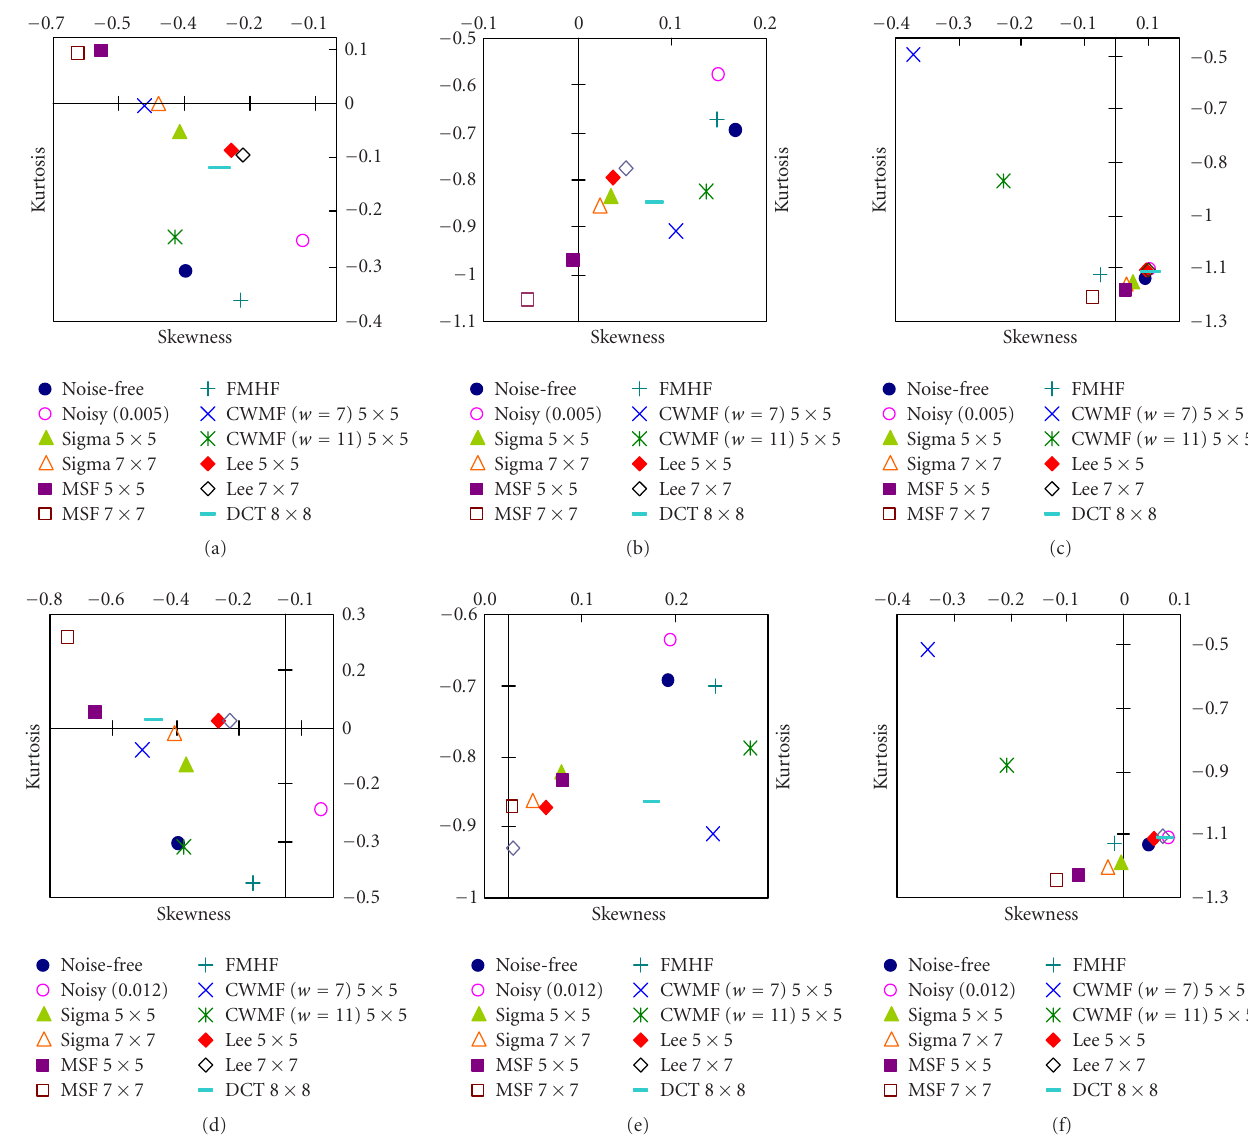
Figure 5: Joint graphical representation of kurtosis and skewness for original and noisy textures and these textures are processed by dif- ferent detail preserving filters: (a), (d) left-bottom, (b), (e) right-bottom, and (c), (f) left-top textures in Figure 1, corrupted by Gaussian multiplicative noise: (a), (b), (c) with σ 2 µ = 0 . 005 and (d), (e), (f) with σ 2 µ = 0 .